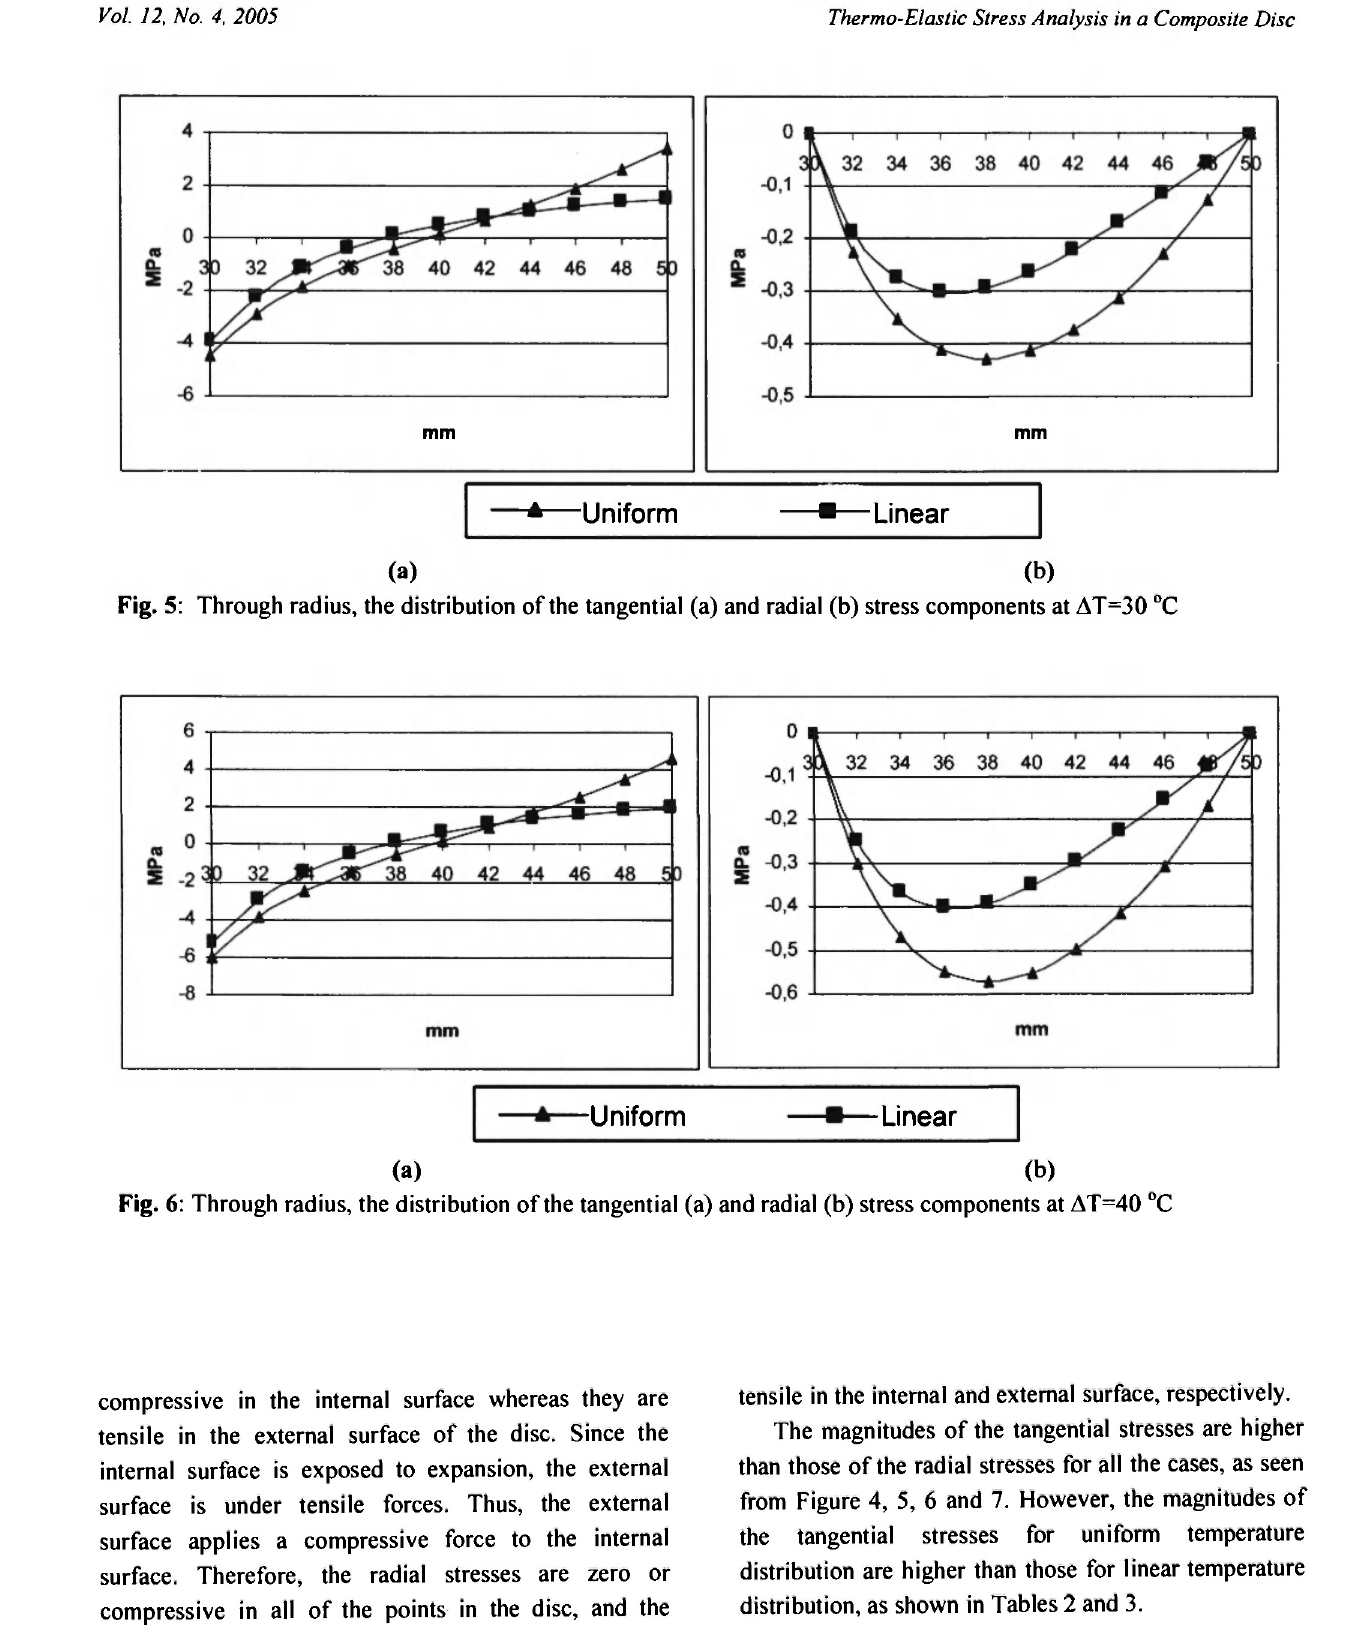
compressive in the internal surface whereas they are tensile in the external surface of the disc. Since the internal surface is exposed to expansion, the external surface is under tensile forces. Thus, the external surface applies a compressive force to the internal surface. Therefore, the radial stresses are zero or compressive in all of the points in the disc, and the tangential stress components are compressive and